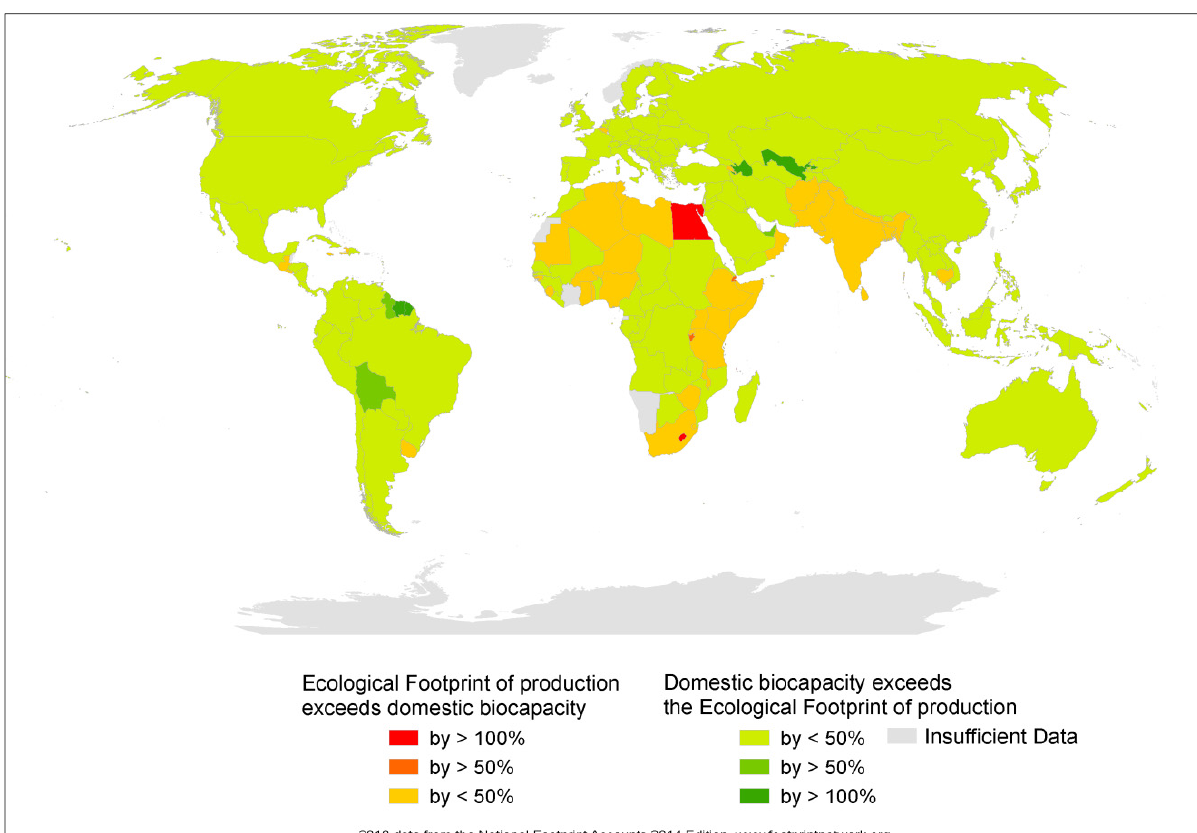
Figure 7. Ecological deficit (EF p > BC) or reserve (EF p < BC) for forest land, by